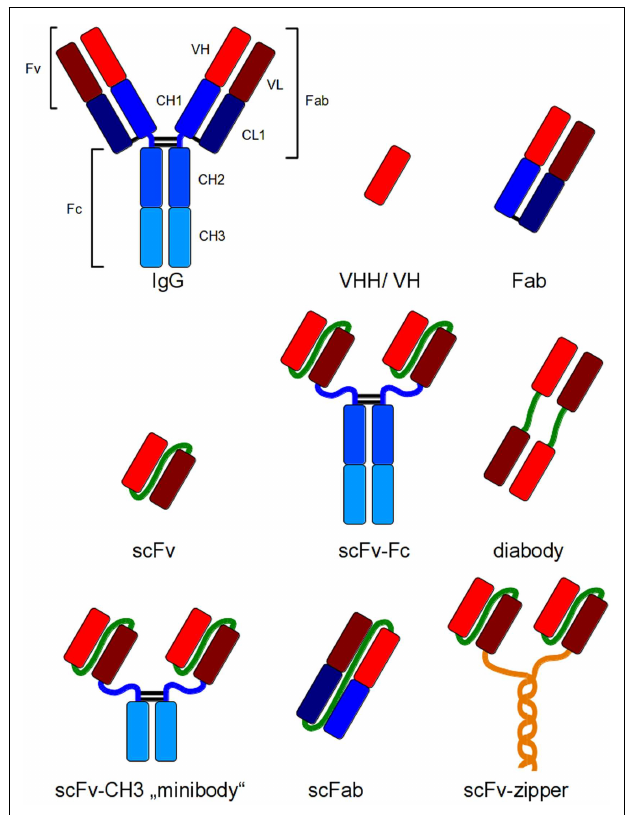
FIGURE 1 | Recombinant antibody formats for different applications compared to IgG. Red and dark red: variable regions; blue: constant regions; green: artificial peptide linkers; yellow: dHLX represents amphiphatic helices used for dimerization of scFv fragments.